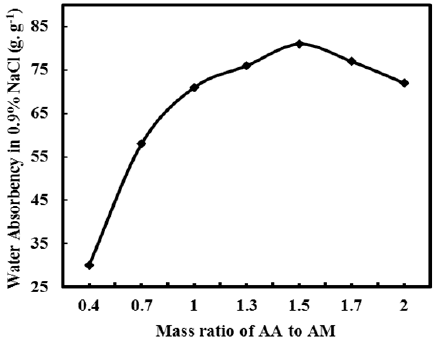
Figure 2. Effect of mass ratio AA/AM on water absorbency of PAA-AM/FA in 0.9% NaCl aqueous solution (polymerization temperature, 70 °C; neutralization degree of acrylic acid (AA), 70%; crosslinker concentration, 0.7%; FA concentration, 50%).